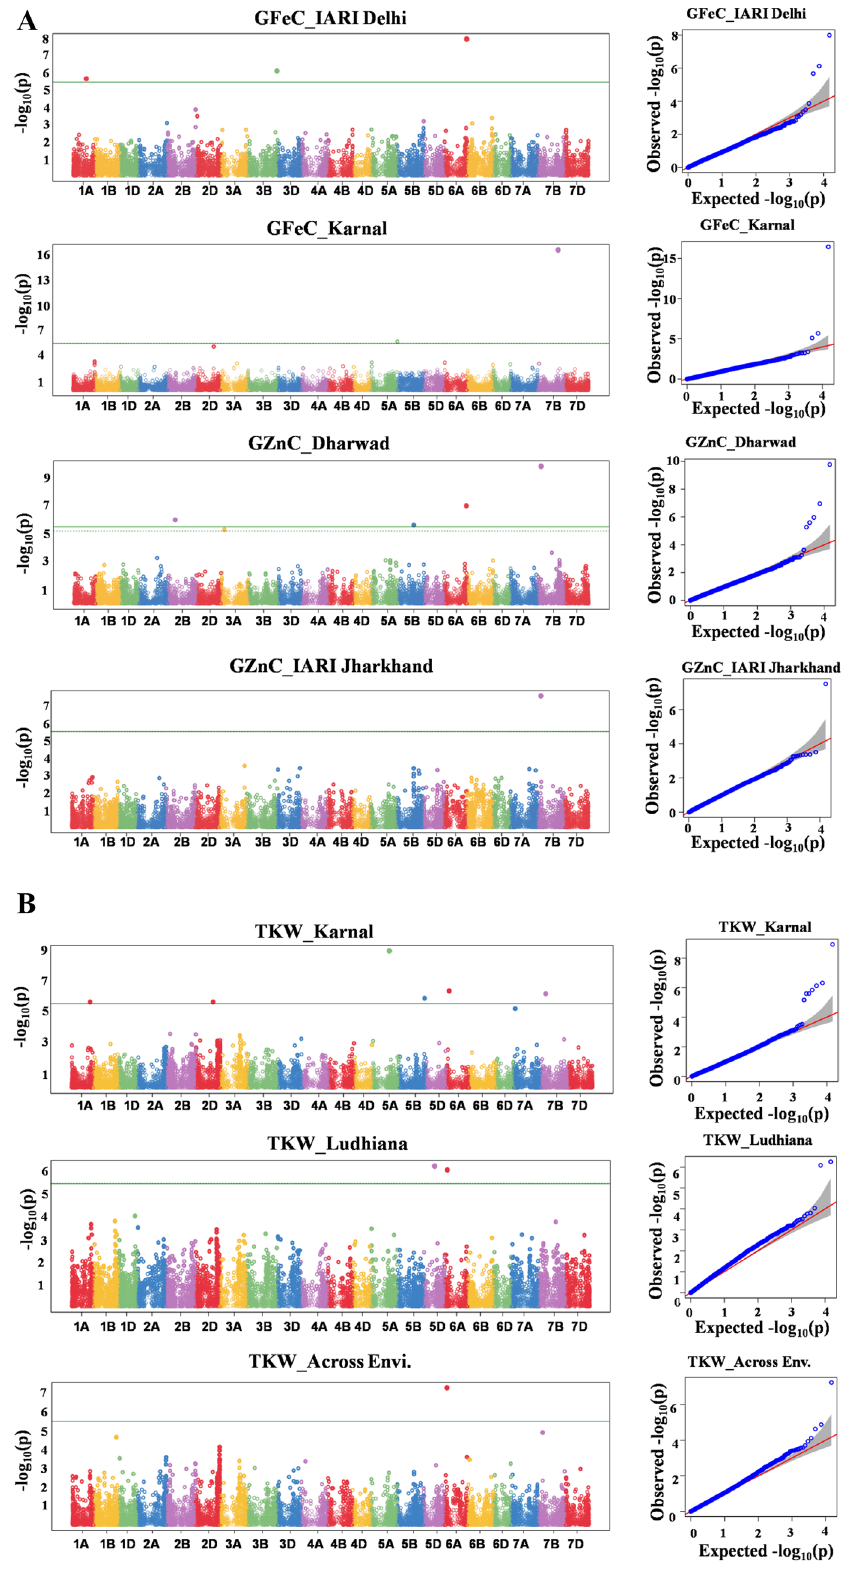
Figure 4. ( A ) Manhattan and respective-QQ plots for grain iron and zinc concentration in GWAS panel phenotyped at Dharwad, IARI Delhi, IARI Jharkhand, Karnal, and Ludhiana during 2020–2021. ( B ) Manhattan and respective-QQ plots for thousand kernel weight in GWAS panel phenotyped at Dharwad, IARI Delhi, IARI Jharkhand, Karnal, and Ludhiana during